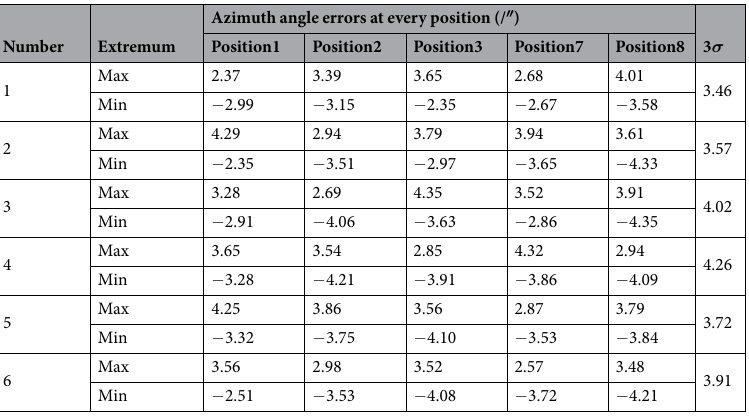
Table 5. The azimuth angle errors of static precision